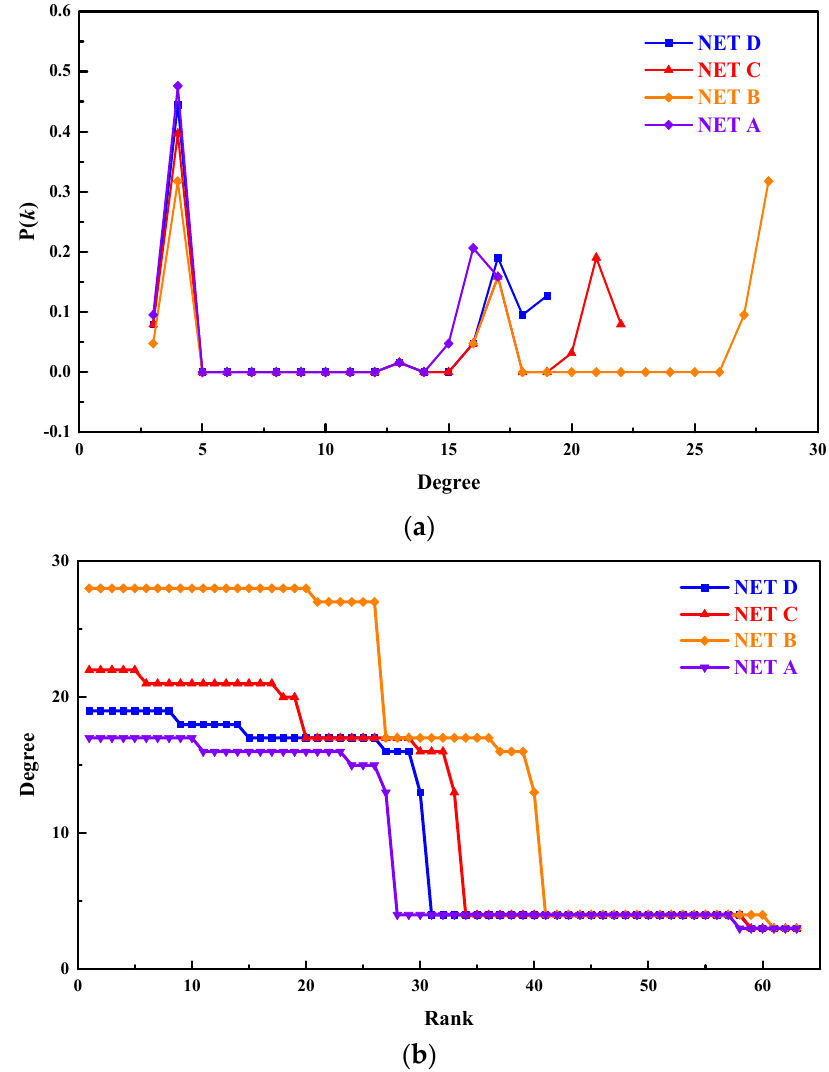
Figure 4. Degree probability distribution and degree distribution. ( a ) Degree probability distribution; ( b ) Degree distribution.